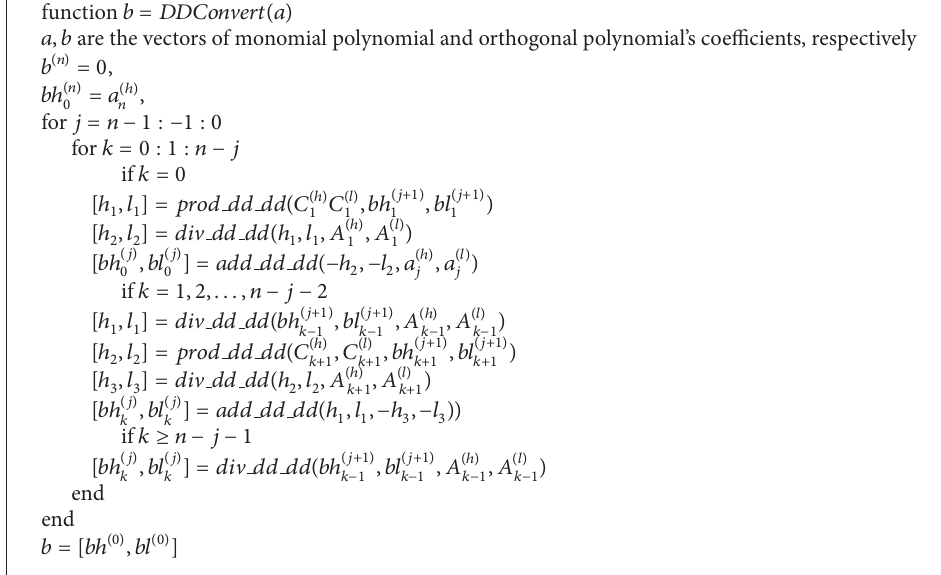
Algorithm 16: DDConvert algorithm for the polynomial from power basis to Legendre